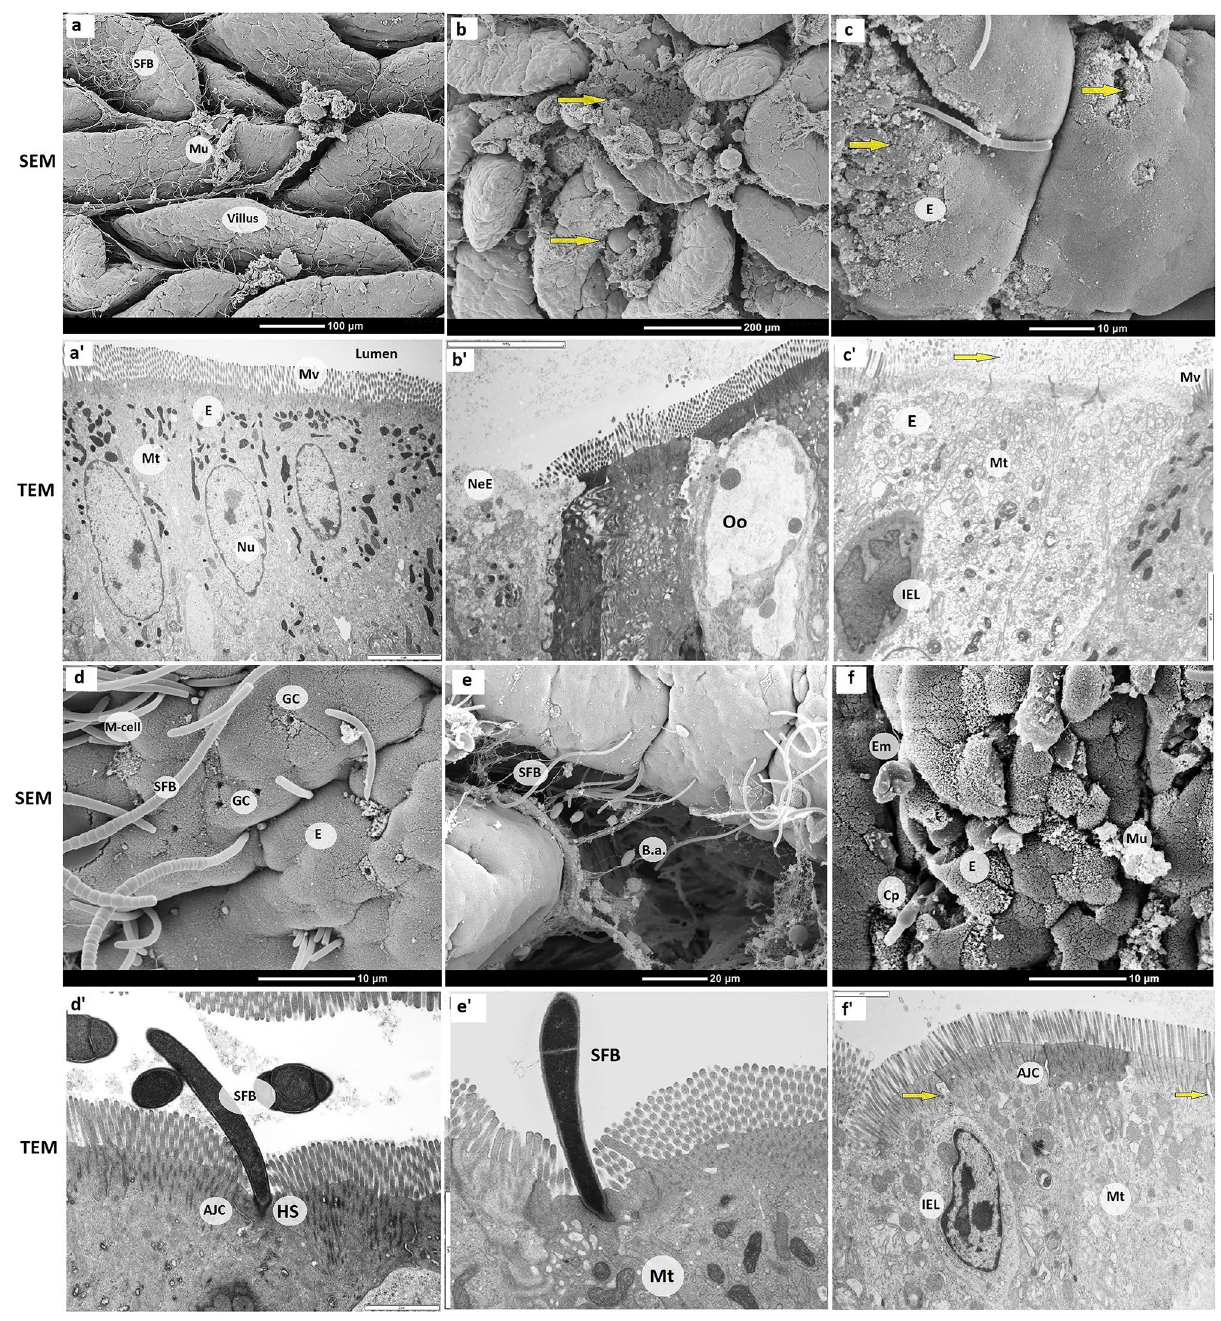
Figure 4. Scanning and transmission electron micrographs of the villi, ileal epithelial cells and other ultrastructural features from 21 d old chicks. Images showing ileal epithelium of a H57 ( a & a ’), NE ( b & b ’, c & c ’, and f & f ’) and NE & H57 ( d & d ’ and e & e ’) birds. SEM and TEM images of each treatment are taken from the same sample (e.g. a & a ’). Note, images of control and H57 birds were very similar in terms of villus or cellular damage, therefore only an image from H57 bird is shown in this figure. Figures 5a and 6a show images from a control bird. H57 chicks were fed a basal wheat-soybean diet supplemented with Bacillus amyloliquefaciens strain H57 at an average dose of 2.48 × 108 CFU/g feed; NE chicks were exposed to a coinfection with a high dose of Eimeria spp. vaccine and Clostridium perfringens (Cp), while NE & H57 chicks were exposed to NE and fed the control diet supplemented with the probiotic. Labelled are on images: a & a ’, the villus, mucus (Mu), segmented filamentous bacteria (SFB), enterocyte, mitochondria (Mt), nucleus (Nu) and microvilli (Mv); images b & b ’ and c & c ’ from NE birds, yellow arrows show damage of villus tips and damage of epithelium and microvilli; enterocyte undergoing necrosis (NeE), Eimeria oocyte (Oo) and damaged mitochondria (Mt) and microvilli (Mv). In images d & d ’ and e & e ’ identified are a microfold cell (M-cell), goblet cells (GC), segmented filamentous bacteria (SFB) with the holdfast segment (HS), and Bacillus amyloliquefaciens (B.a.), while in images f & f ’ displayed are Cp and an Eimeria sporulated oocyte (Em), mucus (Mu) and enterocyte (E), apical junctional complex AJC (yellow arrow), swelling and vacuolization of mitochondria (Mt), and intraepithelial lymphocytes (IEL). For TEM images scale bars are: a ’, b ’, and c ’ = 5 µM; d ’, e ’ and f ’ = 2